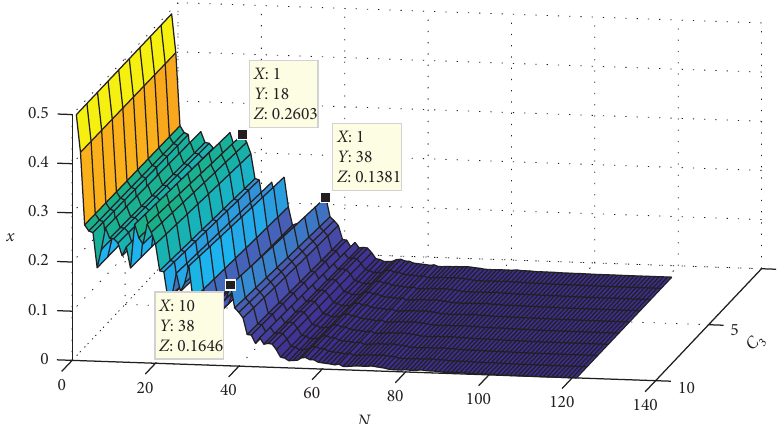
Figure 2: The impact of substantive innovation cost ( C